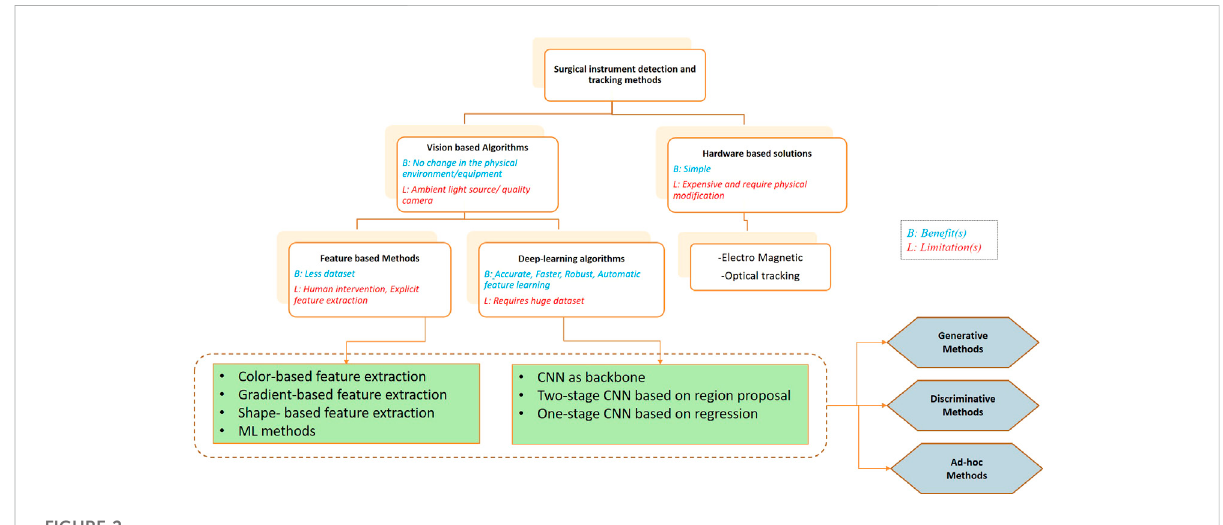
FIGURE 2 Categorization of methods for surgical instrument detection and